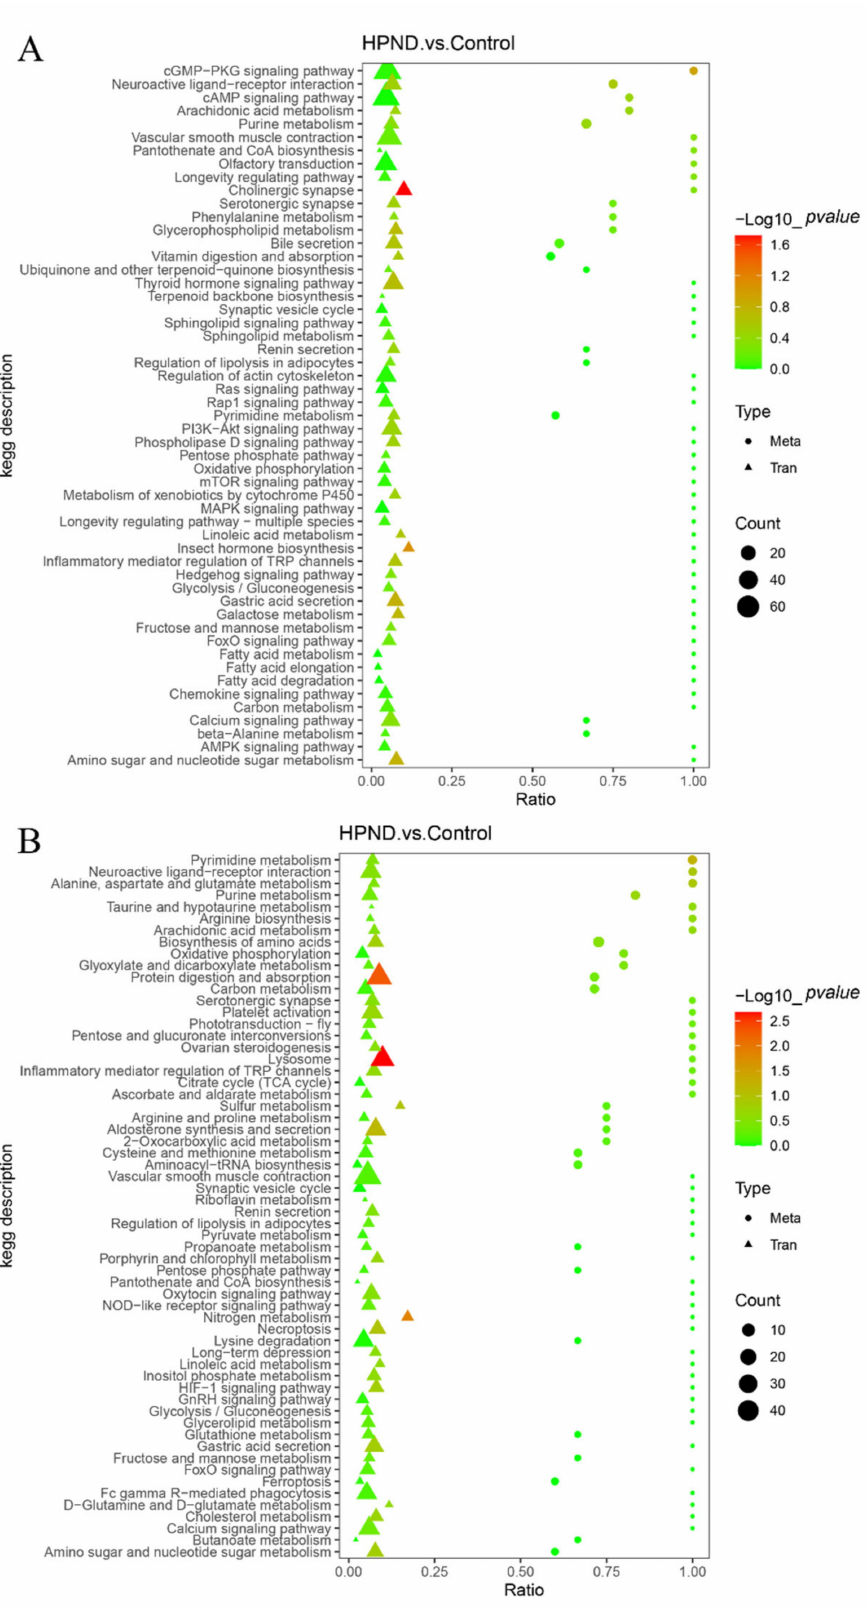
Figure 6. KEGG enrichment analysis for differentially expressed genes and metabolites (( A ), POS mode; ( B ), NEG